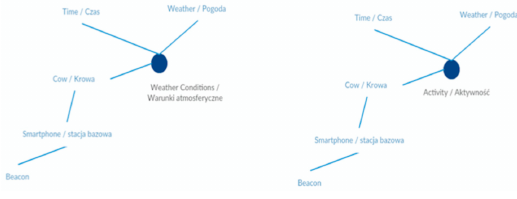
Figure 5. Models describing analytical structure.